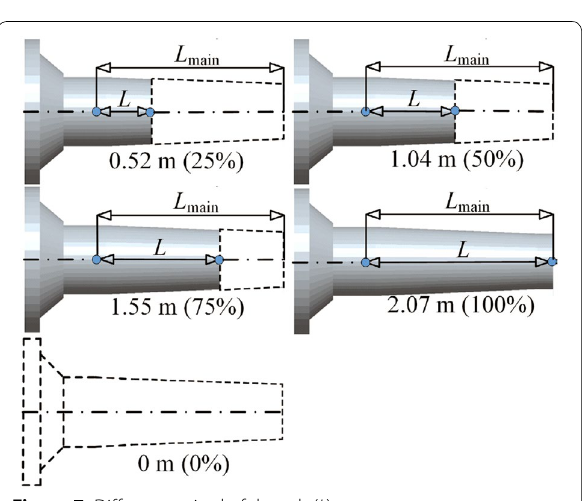
Figure 7 Different main shaft length ( L